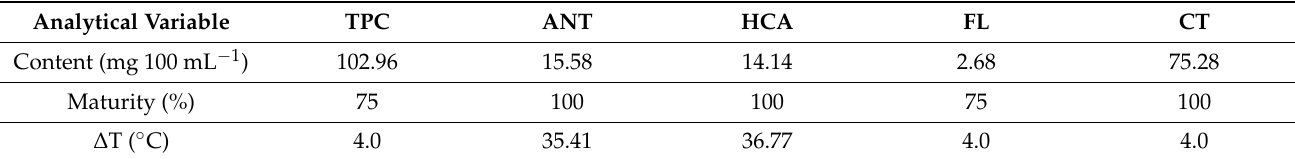
Table 7. Optimal HPU parameters for lowest ∆ T and maturity with maximum mg 100 mL − 1 of polyphenols in